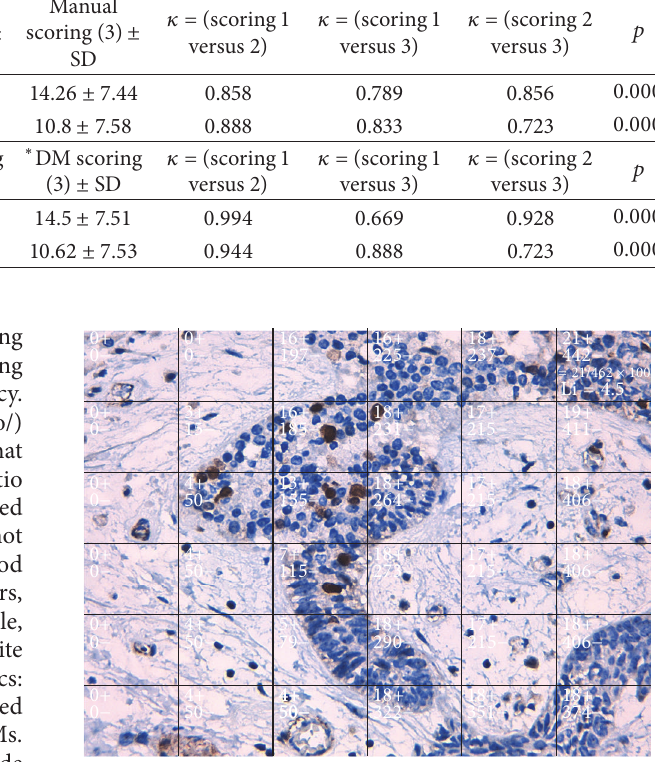
Figure 1: Photomicrograph of a solid ameloblastoma specimen at 400x magnification. Each box in this photomicrograph represents a cumulative number of nuclei with positive and negative Ki-67 staining. The last field shows the labeling index, which indicates the number of Ki-67-positive cells (method proposed by Bologna- Molina et al.